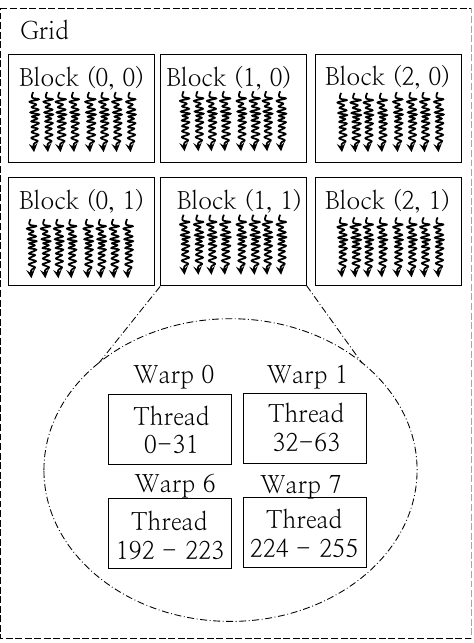
Figure 3. Grid, Thread, Block, and Warp configuration in